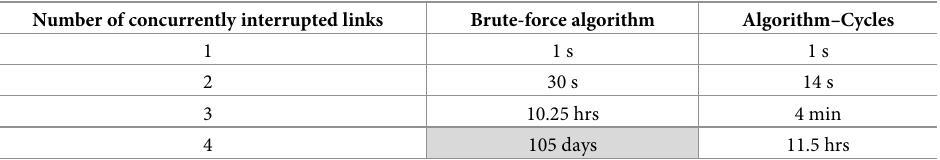
Table 2. Duration of the computation for the Zlı´n